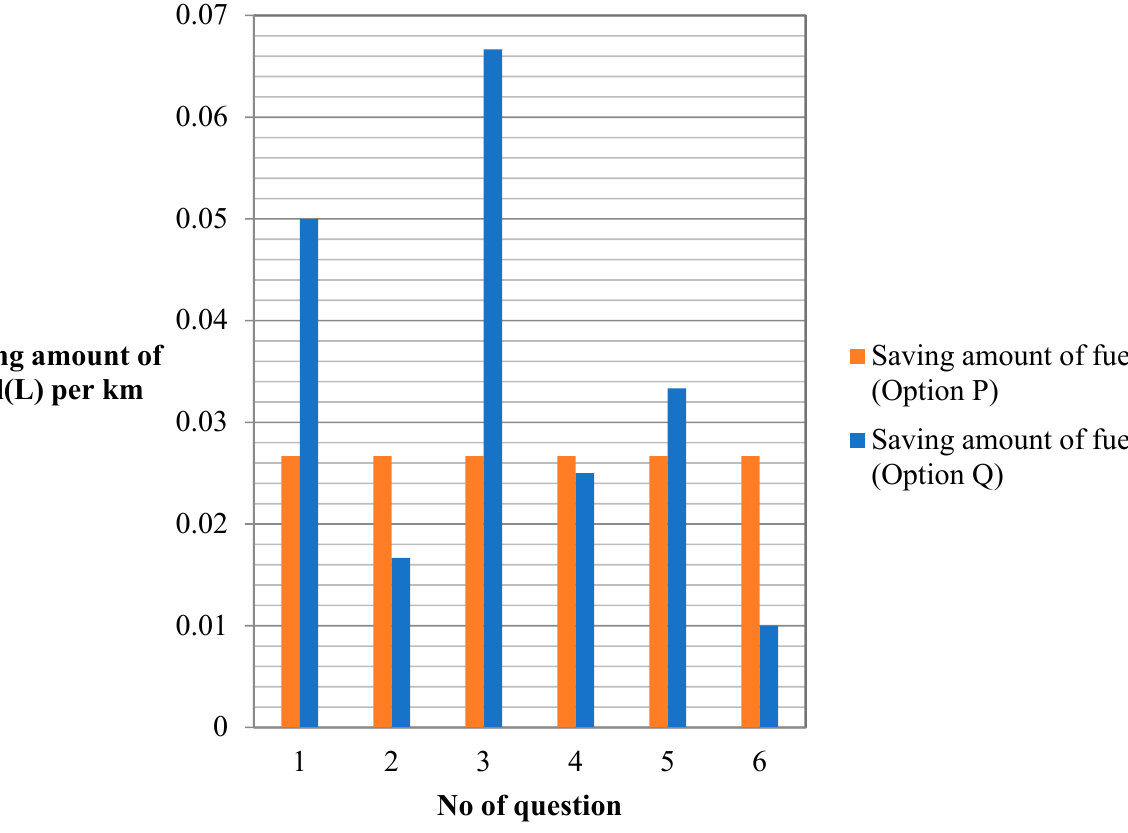
Figure 1. Saving amount of fuel (L) per km in each question and option.